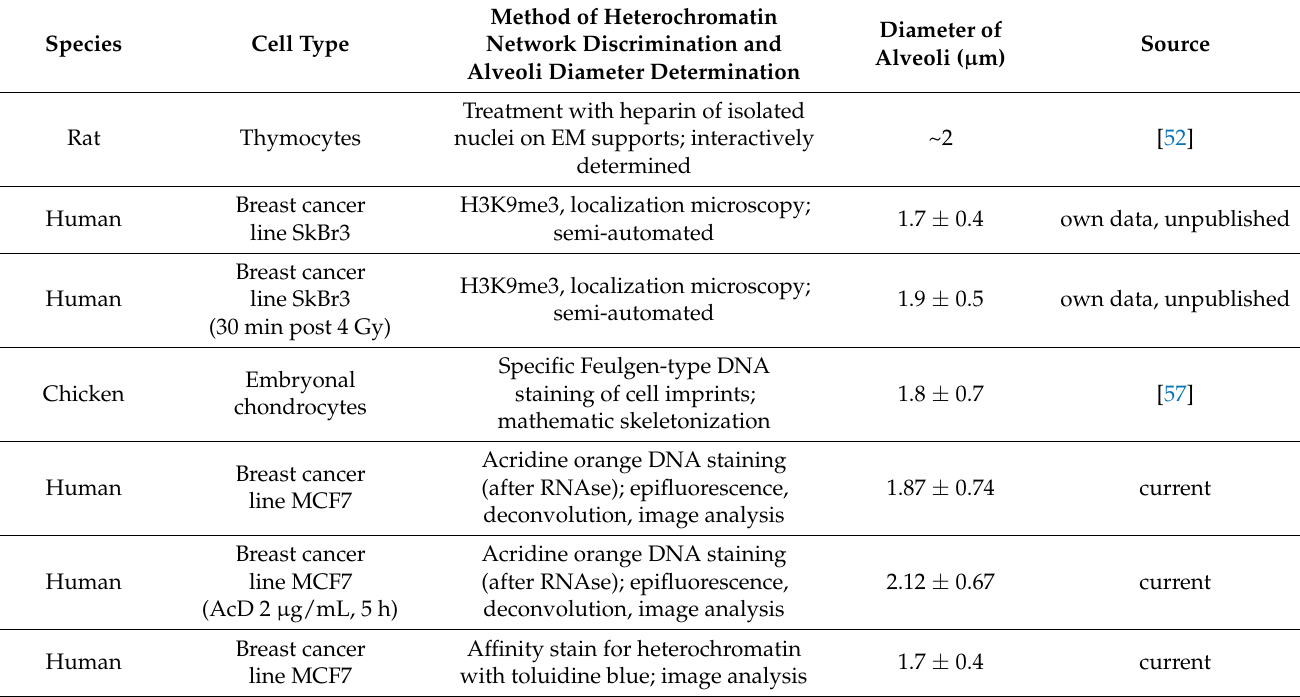
Table 1. The average diameter of the heterochromatin network alveoli was determined by five different methods in chicken, rat and human